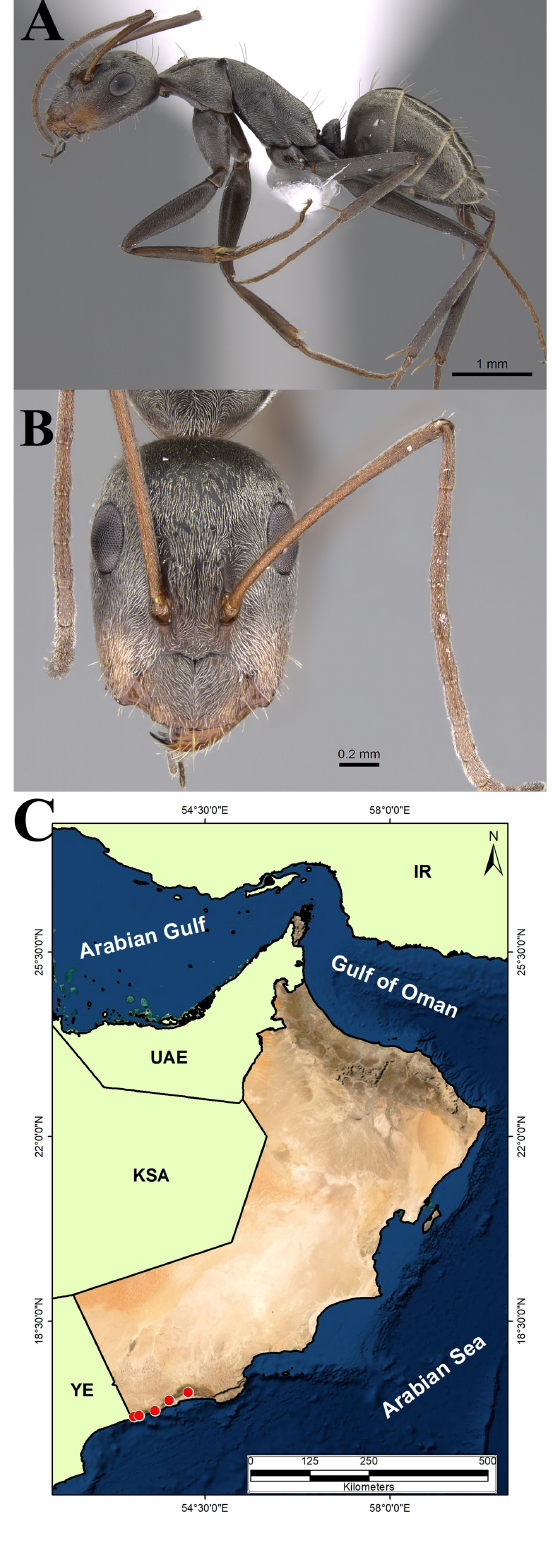
Fig. 7. Camponotus flavomarginatus Mayr, 1862, major worker (CASENT0922854, AntWeb.org (Michele Esposito). A . Body in profile. B . Head in full-face view. C . Distribution